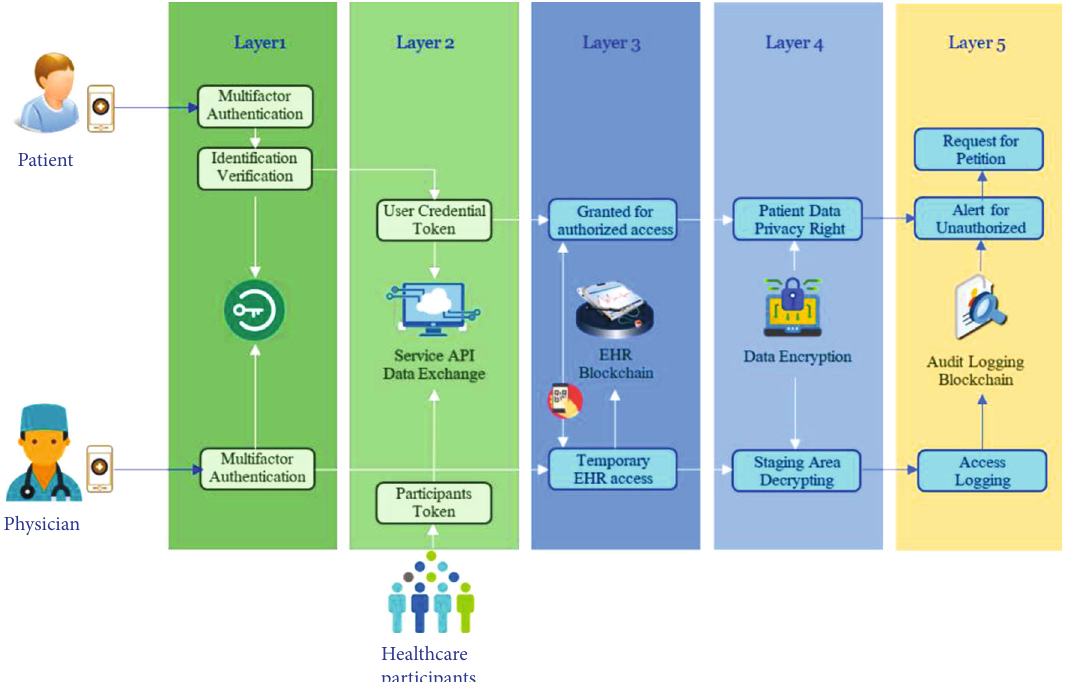
Figure 8: Security design for a large-scale telehealth